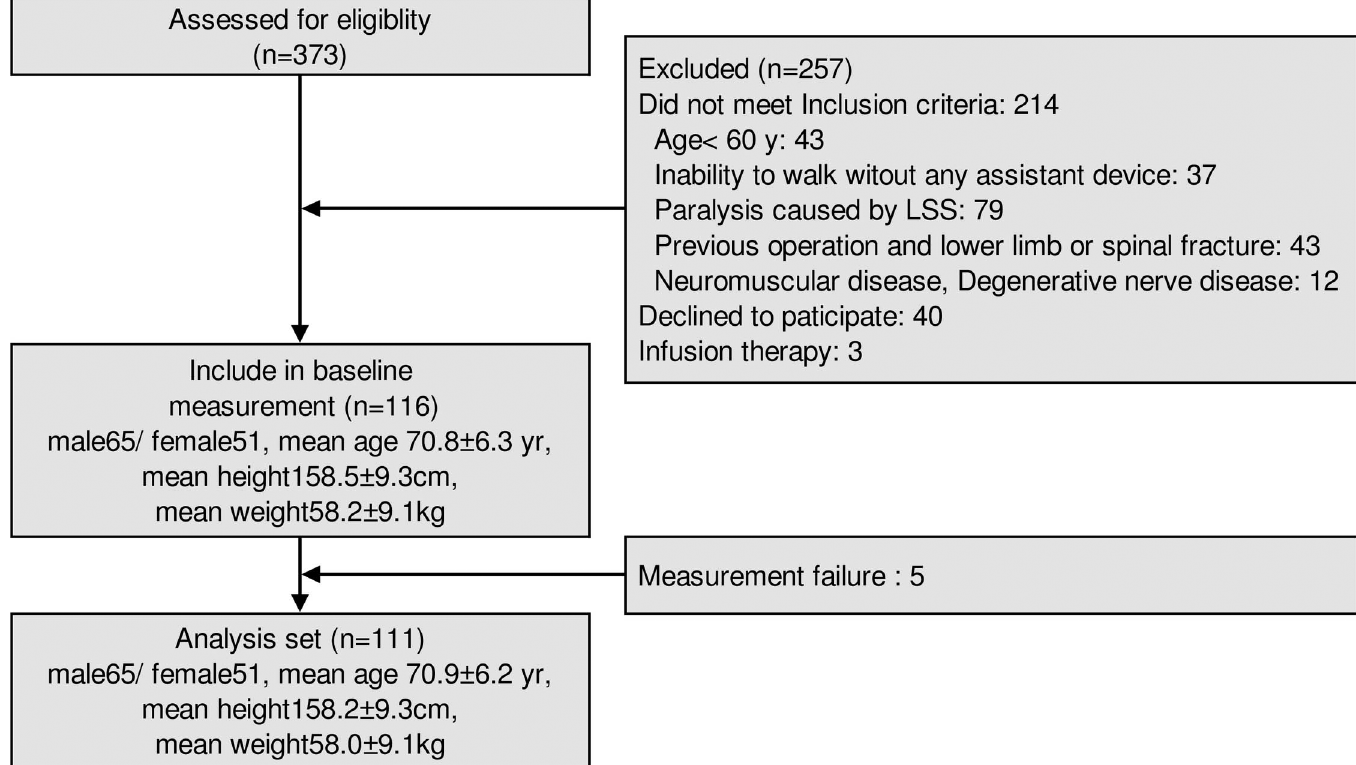
Fig 2. Study follow diagram. FRF, floor reaction